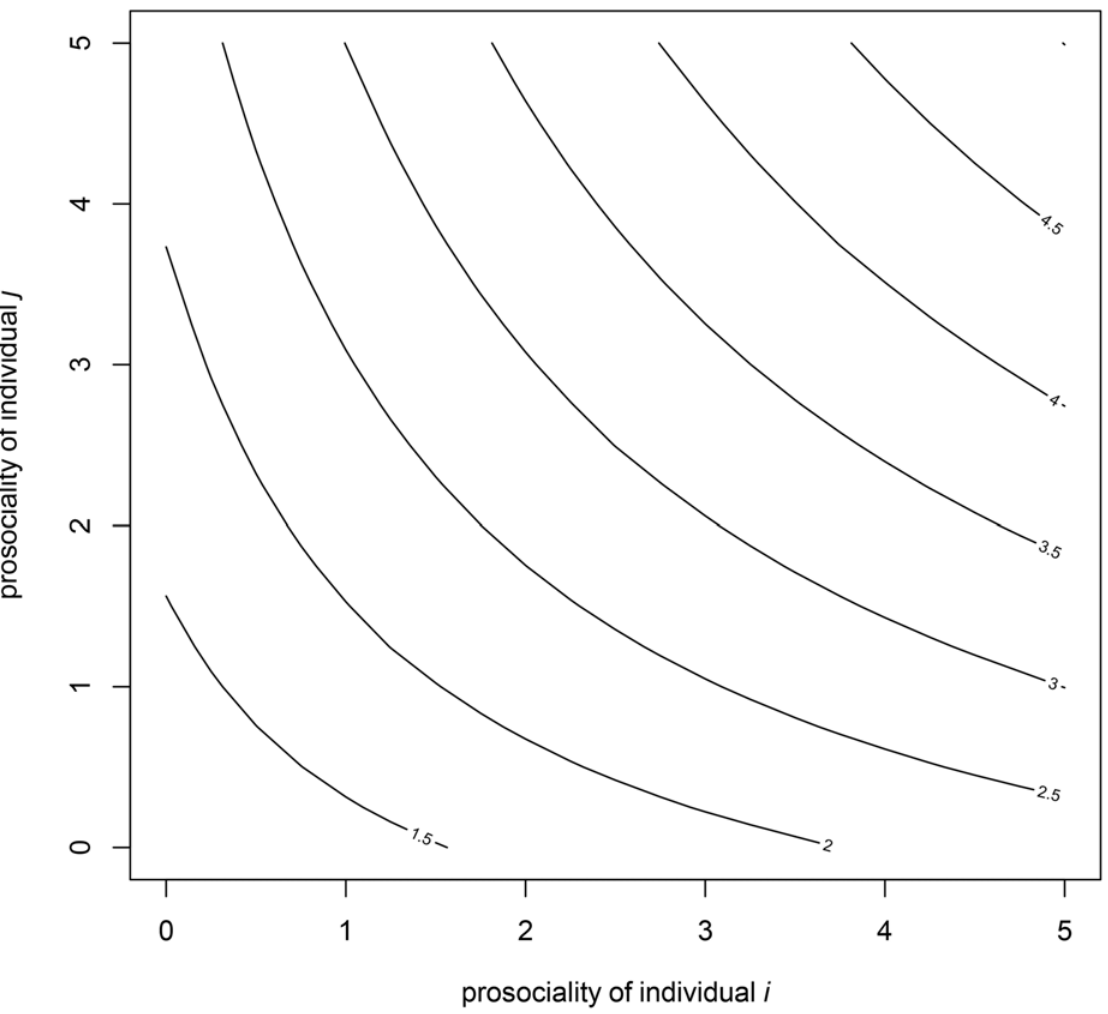
Fig 2. Contour plot for the prosocial edge covariate for ERGM 2. The numbers on the x and y axes correspond to the prosociality scores of the actors i and j and the corresponding point in the matrix represents the edgecov value for dyad (i, j), which equals the square root of the product of the two actors ’ prosociality.